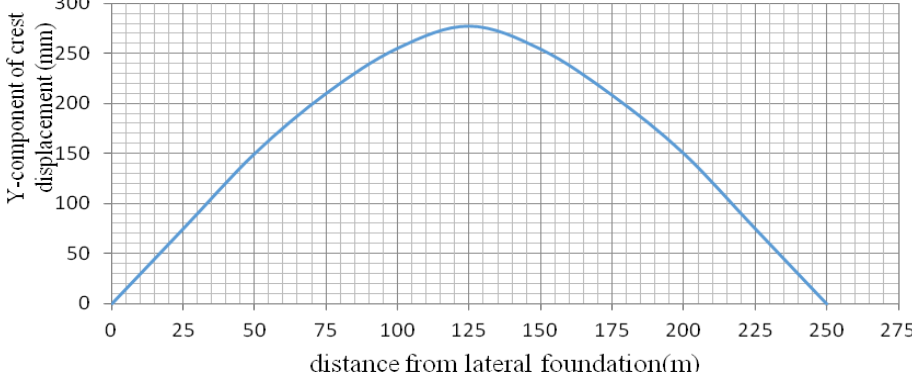
Fig. 5. Displacement value of the dam’s crest perpendicular to the body of the dam (Vertical-direction) (mm) versus the distance from the lateral base